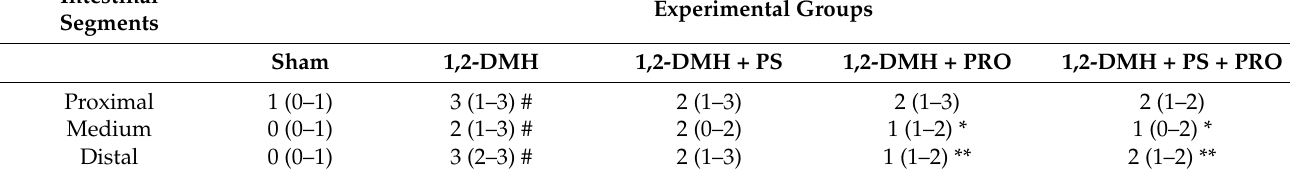
MDA levels were higher in the 1,2-DMH group compared to the Sham group. 1,2- DMH + PRO and 1,2-DMH + PS + PRO supplementation signi fi cantly reduced MDA levels in the distal large intestine. In addition, GSH levels were signi fi cantly reduced in the 1,2- DMH group, an e ff ect that was improved by either compounded 1,2-DMH + PS + PRO